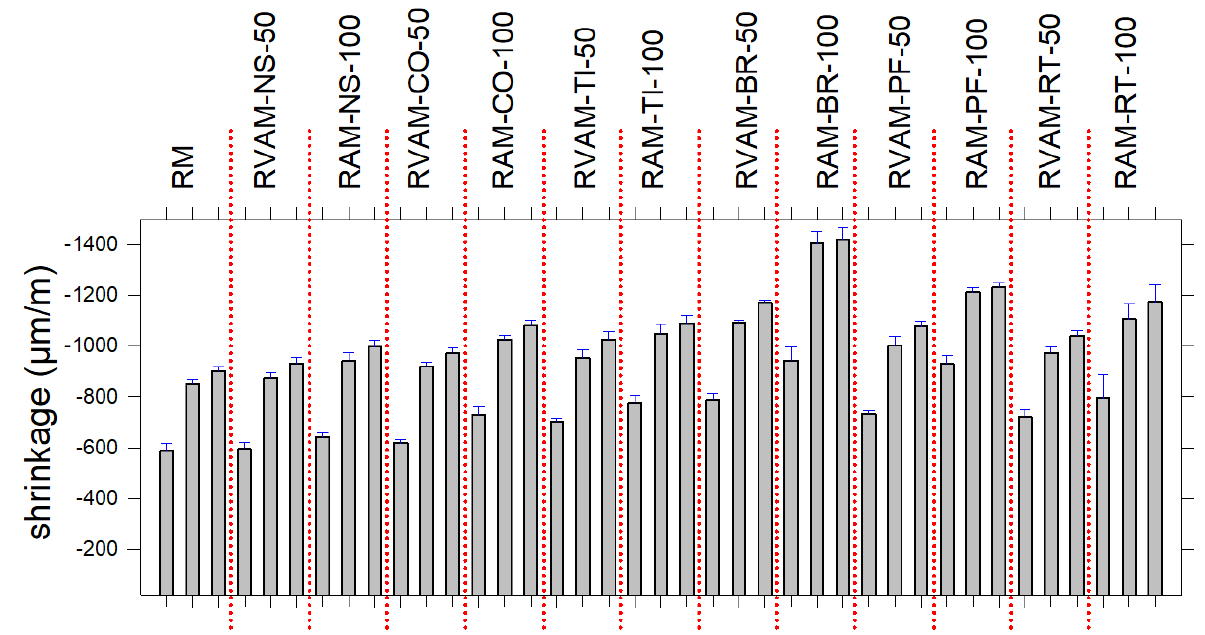
Figure 2. Shrinkage for RM, RVAM and RAM (Table S3) at 14 (left bar), 28 (central bar) and 91 (right bar) days.